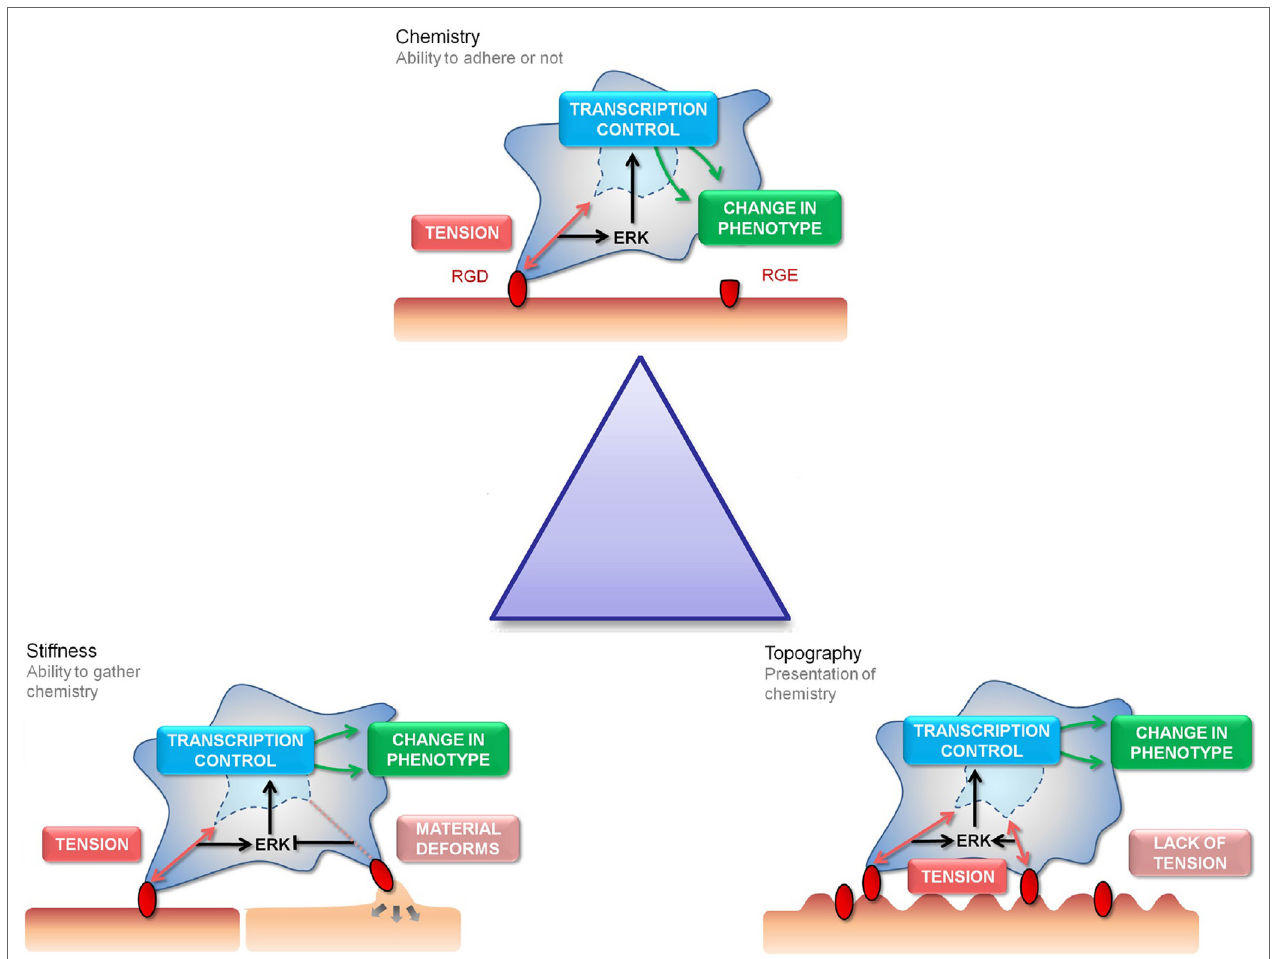
FiGURe 1 | The “Triangle” of material/surface interface . The “triangle” of materials refers to variations in chemistry, stiffness, and nanotopography to control the interactions with MSC focal adhesions. The three cartoon panels show MSC adhesion to chemical, stiffness, and topographically modified surfaces and how this influences stem cell tension and signaling and, hence, subsequent differentiation and phenotype (as will be discussed). The cells are shown to extend filopodia to “find” adhesion ligands (shown in red). Binding of the cell through focal adhesions to these ligands creates tension and activates signaling. Chemical functionality can be used to fabricate areas of high adhesion (red) or low adhesion (capped in green) for the cells to respond to (the cell is shown in a 3D scaffold). Stiffness will affect the cells ability to produce tension through focal adhesions formation (the cell is shown on a planar surface). Topography will present the adhesion ligands to the cells in either a favorable or unfavorable manner, again affecting adhesion and subsequent tension and signaling (the cell is shown on a 2D